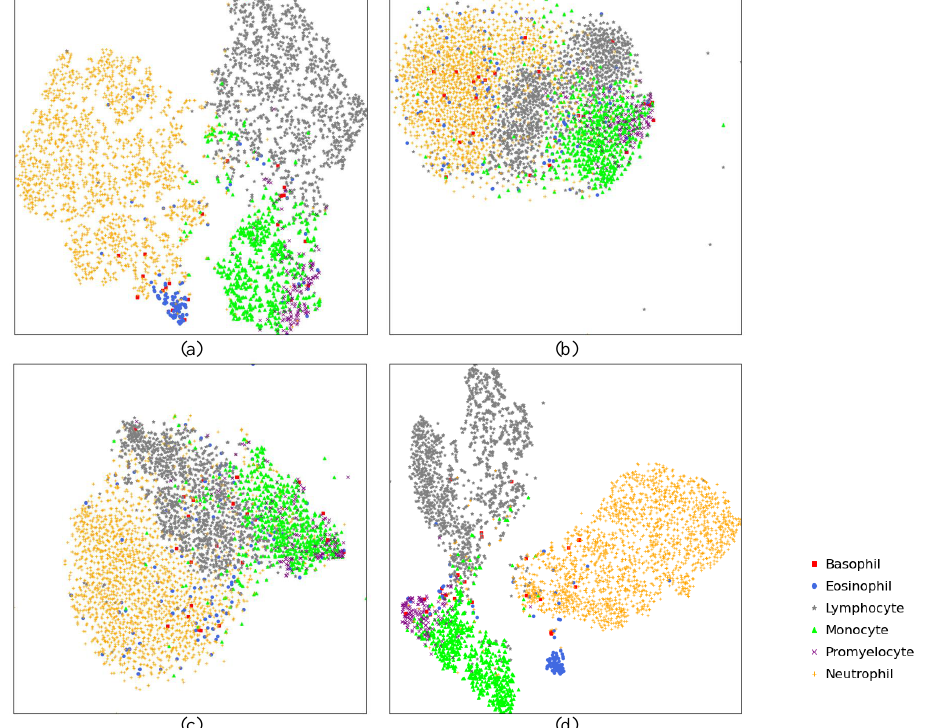
Figure 5. The learned feature of the four models visualized through t-SNE. For each image in the testing set, we save the parameters of the last fully-connected layer during the inferencing process. The dimensions of the last fully-connected layer of our network and ResNet-34 are 512; the ResNeXt- 50’s is 2048 and the VGG-19’s is 4096. The dimension of the embedded space was set to 2 for better visualization and PCA was applied to initialize the embedding space. ( a ) Our model; ( b ) ResNet-34; ( c ) ResNeXt-50. ( d ) VGG-19.